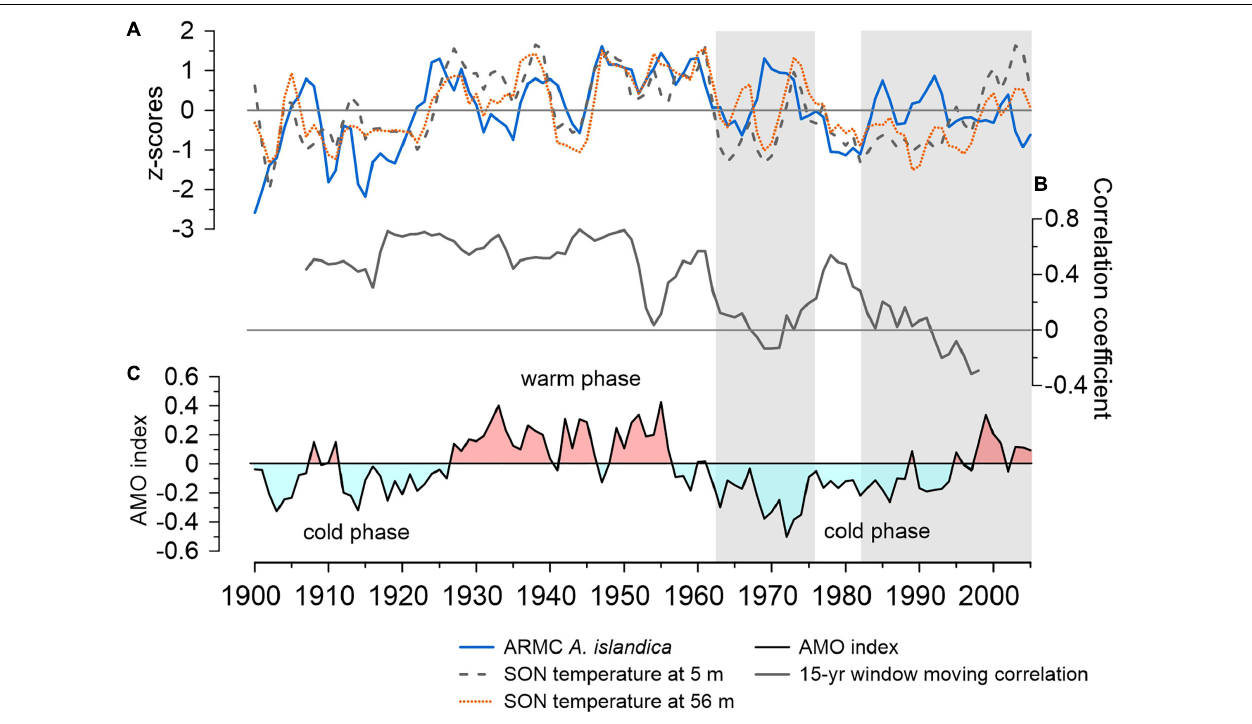
FIGURE 3 | (A) Normalized growth increments of A. islandica (blue line) and autumn (SON) water temperature at 5 m (gray dashed line) and 56 m depth (orange dotted line) between 1900 and 2005. A 5-year low-pass filter (i.e., Savitzky-Golay) was applied to the time series. The water temperatures were extracted at the approximate collection site (66 ◦ N, 18 ◦ W). (B) The 15-year running correlation between ARMC and temperature signal at 56 m depth. The gray-shaded sections represent periods in which the shell growth variability does not synchronize with the temperature signal. (C) Atlantic Multidecadal Oscillation (AMO) index (van Oldenborgh et al., 2009) showing positive (red shade) and negative (light blue shade) phases in the 1900–2005